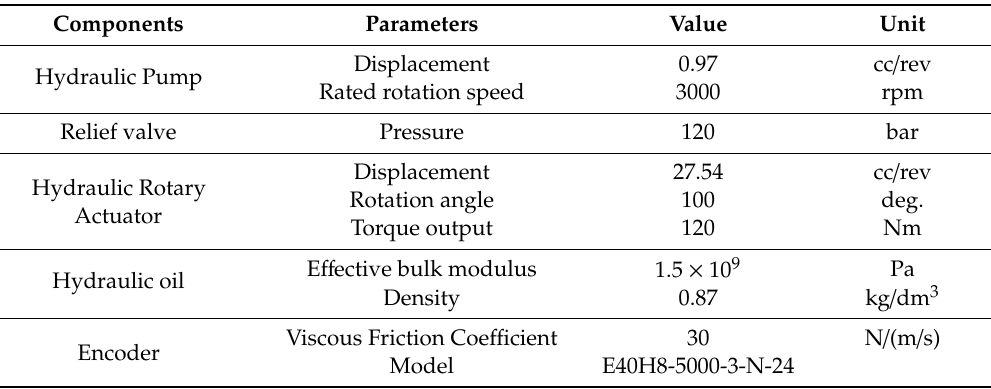
Table 4. Specification parameter of the EHRA system.